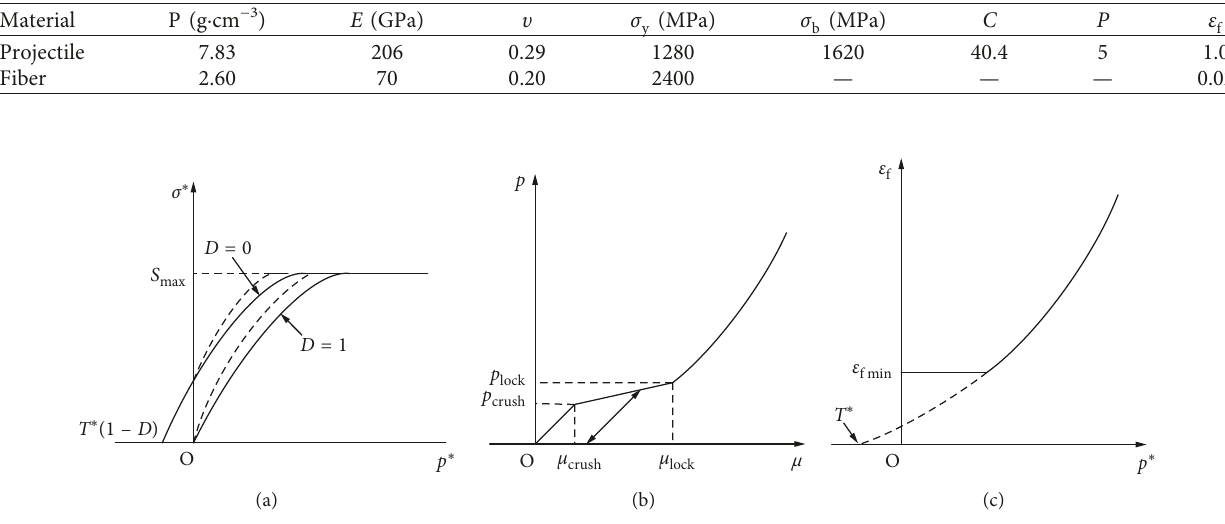
Figure 10: Description of the HJC model: (a) strength; (b) pressure; (c)